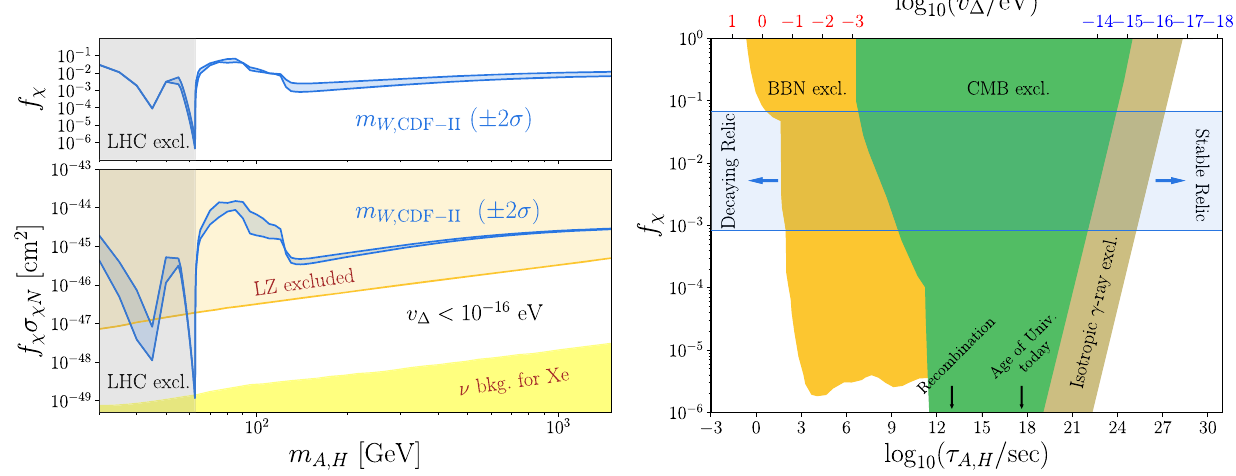
Fig. 9 (Upper left) Sum of the relative relic abundances for H and Higgs as the gray shaded region. (Right panel) Constraints on the rela- A in the type-II HTM with respect to that of cold dark matter f χ = tive abundance of visibly decaying relic with respect to cold dark matter (cid:18) /(cid:18) = m = m as a function of their lifetime. 95% CL constraints from BBN [129], H + A c as a function of m H , A H A for parameters that CMB [130,131], and isotropic γ -ray backgrounds [132] are shown as explain the measured m W , CDF-II within 2 σ . (Lower left) Sum of the yellow, green, and brown shaded regions. We highlighted the range of direct detection cross sections times the relative abundance for cosmo- f χ that explains m W , CDF-II as the blue band with arrows indicating the logically stable H and A for parameters that explain the measured m W allowed lifetimes for stable massive relic and decaying massive relic. In by CDF-II within 2 σ (blue band) (assuming v (cid:4) < 10 − 16 eV). 95% CL the lifetime axes, we indicate the age of Universe at recombination and constraints from the LZ experiment with 5.5 ton · 60 day exposure [127] today with black arrows. In the upper axes, we show the corresponding are shown as the orange shaded region. The neutrino background for values of v (cid:4) for m A = 65GeV and m A = 1 . 5TeV as red and blue a xenon target [128] is shown as the yellow shaded region. For both panels, we added constraints from the exotic decays of the SM-like ticks, respectively. See text for more